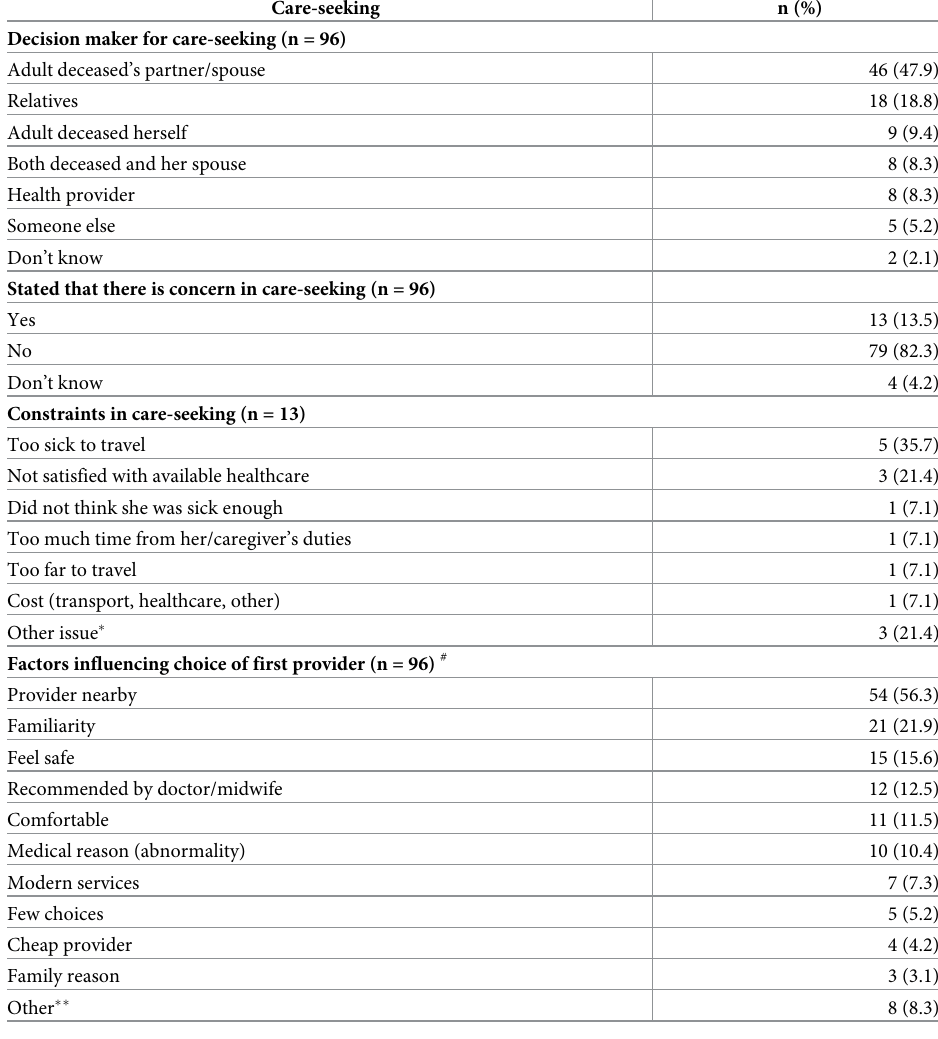
Table 3. Care-seeking among pregnancy-related death cases who sought formal care (n = 96) in Jember District, 2017–2018.